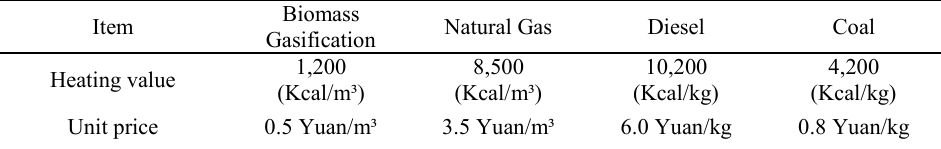
Table 2. Economical comparison between biomass gasification and fossil fuel for heat